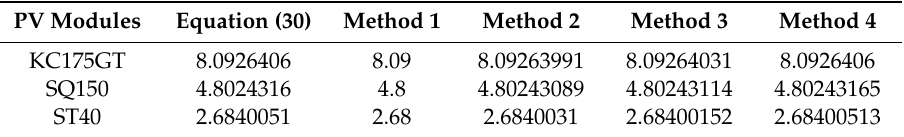
Table 5. Calculated photocurrent (A) using di ff erent